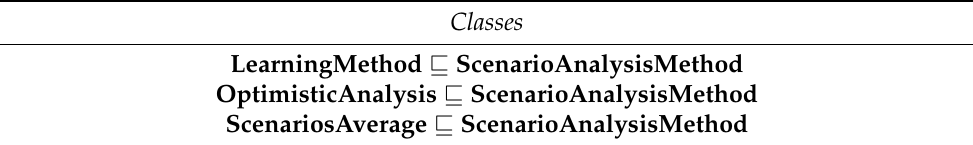
Table 8. AiD-EM Ontology ScenarioAnalysisMethod ’s sub-classes in DL